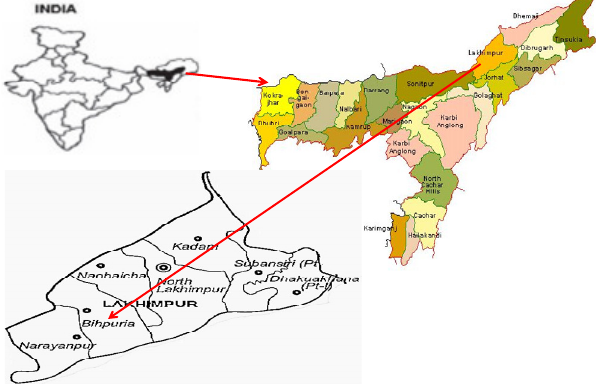
Fig. 1. Map depicting the study site (Loridonga village, Lakhimpur district, Assam,